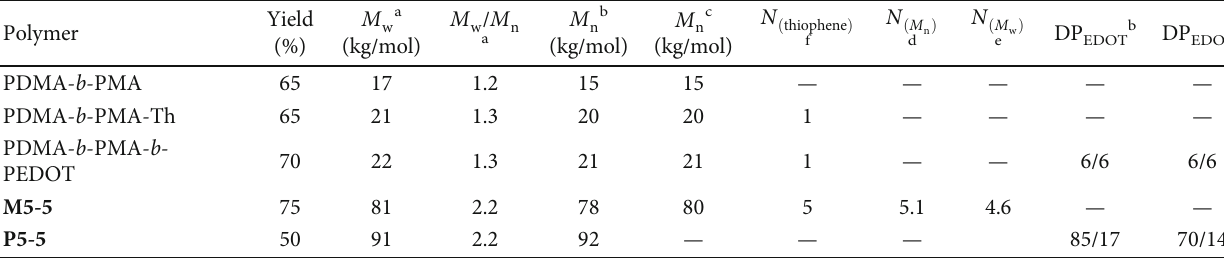
Table 1: Structural characterization of all copolymers.